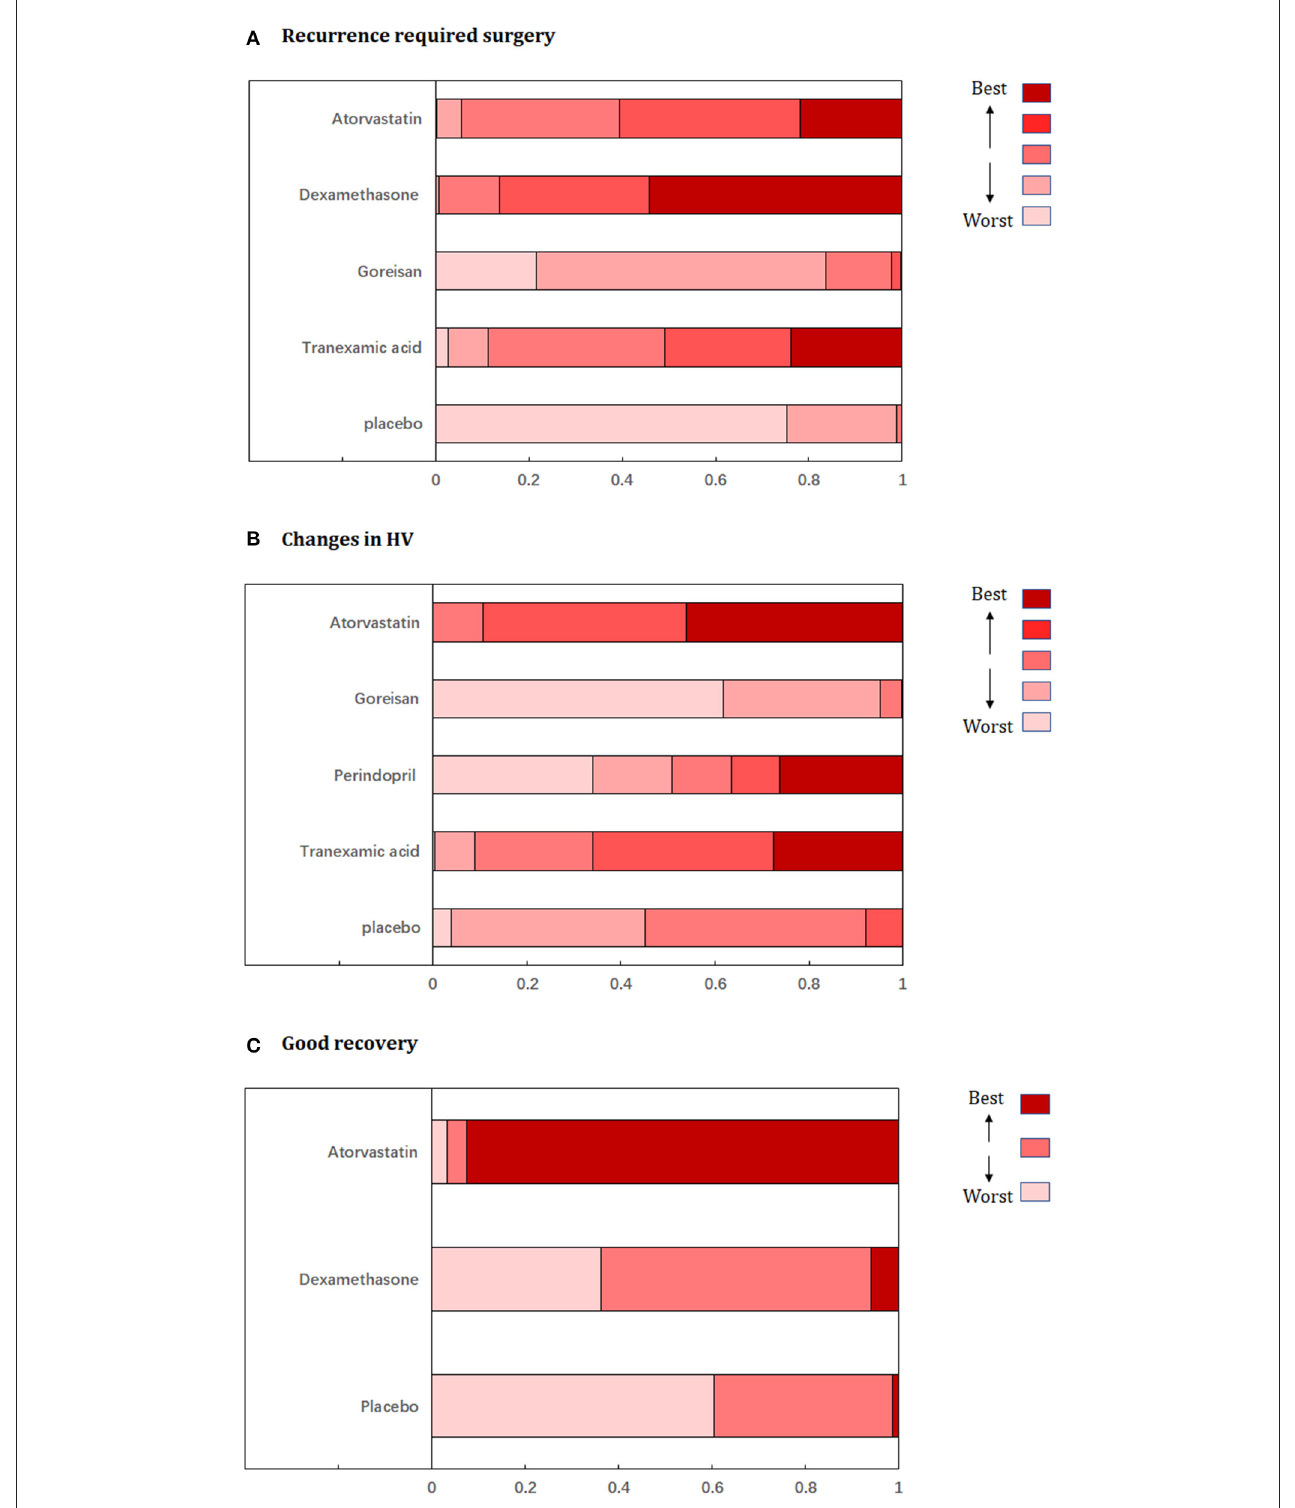
FIGURE 4 | Ranking probabilities graph of each medication for (A) recurrence requiring surgery, (B) changes in hematoma volume, (C) good recovery. HV, hematoma volume.